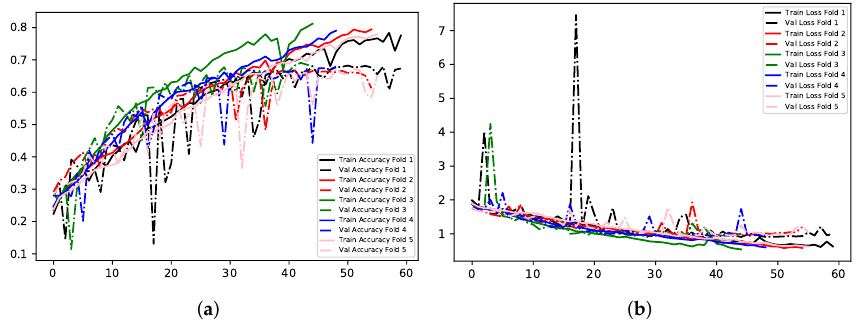
Figure 10. Model A experiment 2 results. ( a ) Accuracy. ( b )